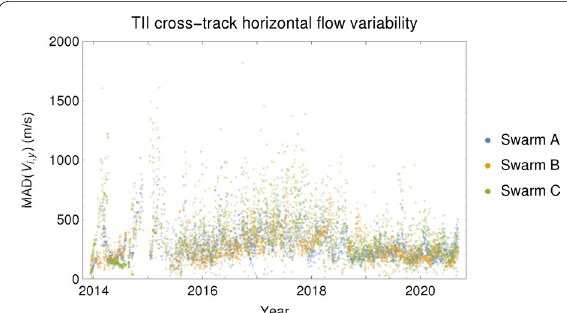
Fig. 17 Daily TII horizontal cross-track ion flow variability from version dataset 0302, estimated from the median absolute deviation of polar cross-track horizontal ( v iy )